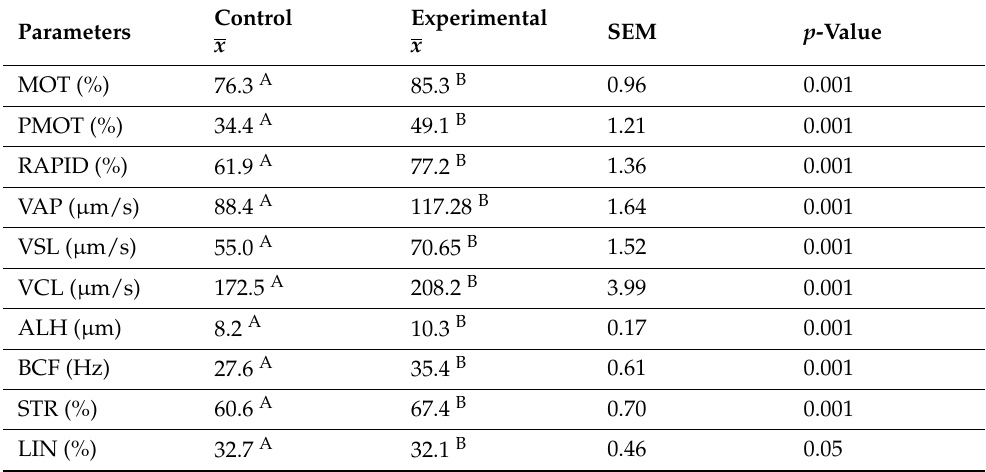
Table 3. Comparison of the sperm motility characteristics, assessed by a computer-assisted semen analyzer (CASA), of fresh semen of boars fed diets top-dressed with linseed oil ethyl esters (mean, n = 6/group, SEM, p